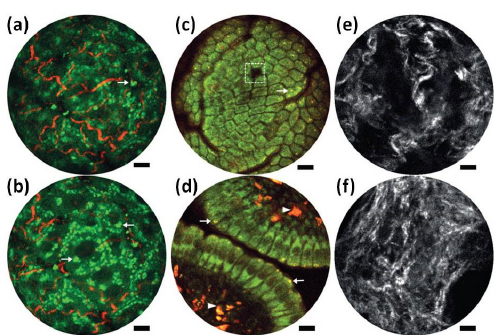
Figure 15. Endomicroscopy two-photon fluorescence (2PF) and second harmonic generation (SHG) label-free structural imaging. ( a , b ) Overlay of intrinsic 2PF and SHG ex vivo images of mouse liver. ( c , d ) Two-photon autofluorescence in vivo images of the mucosa of mouse small intestine. The two detection channels are 417–477 nm for NADH (green) and 496–665 nm for FAD (red). ( e , f ) SHG images of the cervical collagen fiber network acquired through intact ectocervical epithelium of cervices. Scale bars are 10 µm. Reproduced with permission from [85]; published by Nature, 2017.